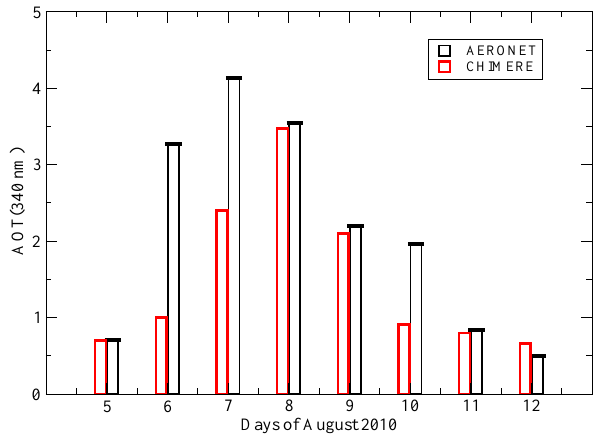
Fig. 5. Temporal evolution of the daily mean observed and modelled AOT(340 nm) over Moscow between 5 and 12 August 2010. Error bars represent the uncertainty range of observations ( ± 0.01; see Dubovik et al. (2000))